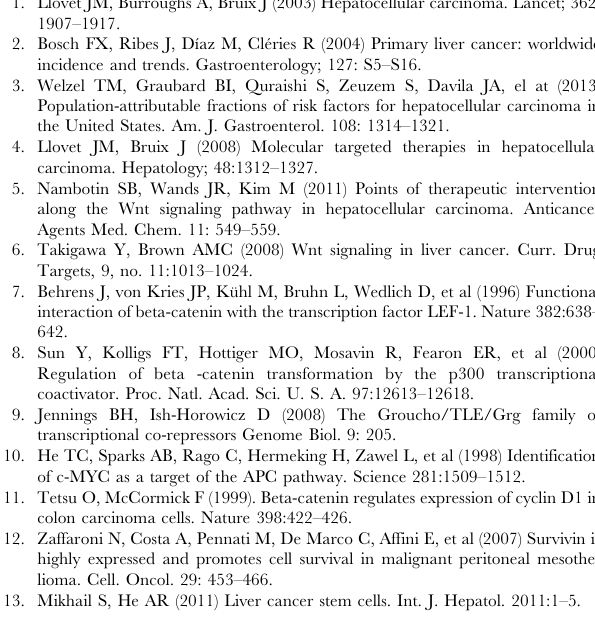
Figure S4 Flow cytometry indicates that a sub-G1 peak is not observed in Huh7 cells treated with FH535, indicating that FH535 does not increased apoptosis as judged by DNA fragmentation.